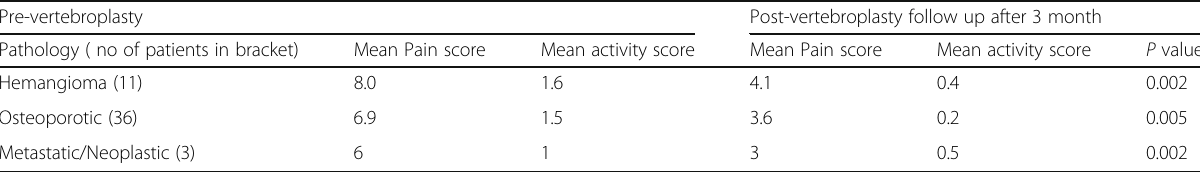
Table 7 Vertebral pathology and amount of Pain relief Pre-vertebroplasty Post-vertebroplasty follow up after 3 month Pathology ( no of patients in bracket)